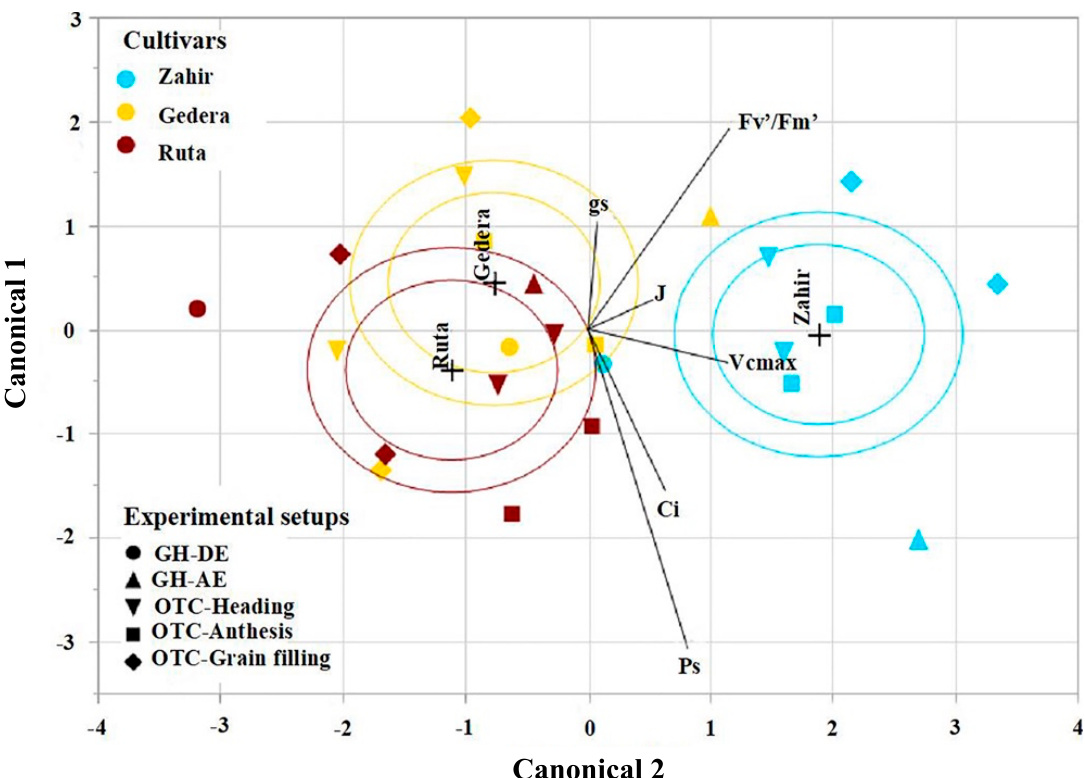
Figure 9. Discriminant analysis between the cultivars under O 3 stress. The biplot indicates the directions of the parameters (maximum carboxylation rate, Vcmax ; rate of electron transport, J ; photosynthetic rate, Ps ; stomatal conductance, gs ; intercellular CO 2 , Ci , and photochemical efficiency, Fv ’ /Fm ’) in the canonical space from both OTCs (seasons I and II), including all phenological stages: heading (OTC-Heading), anthesis (OTC-Anthesis), and grain filling (OTC-Grain filling) and the GH experiment measurements taken during O 3 exposure (GH-DE) and after O 3 exposure (GH-AE).